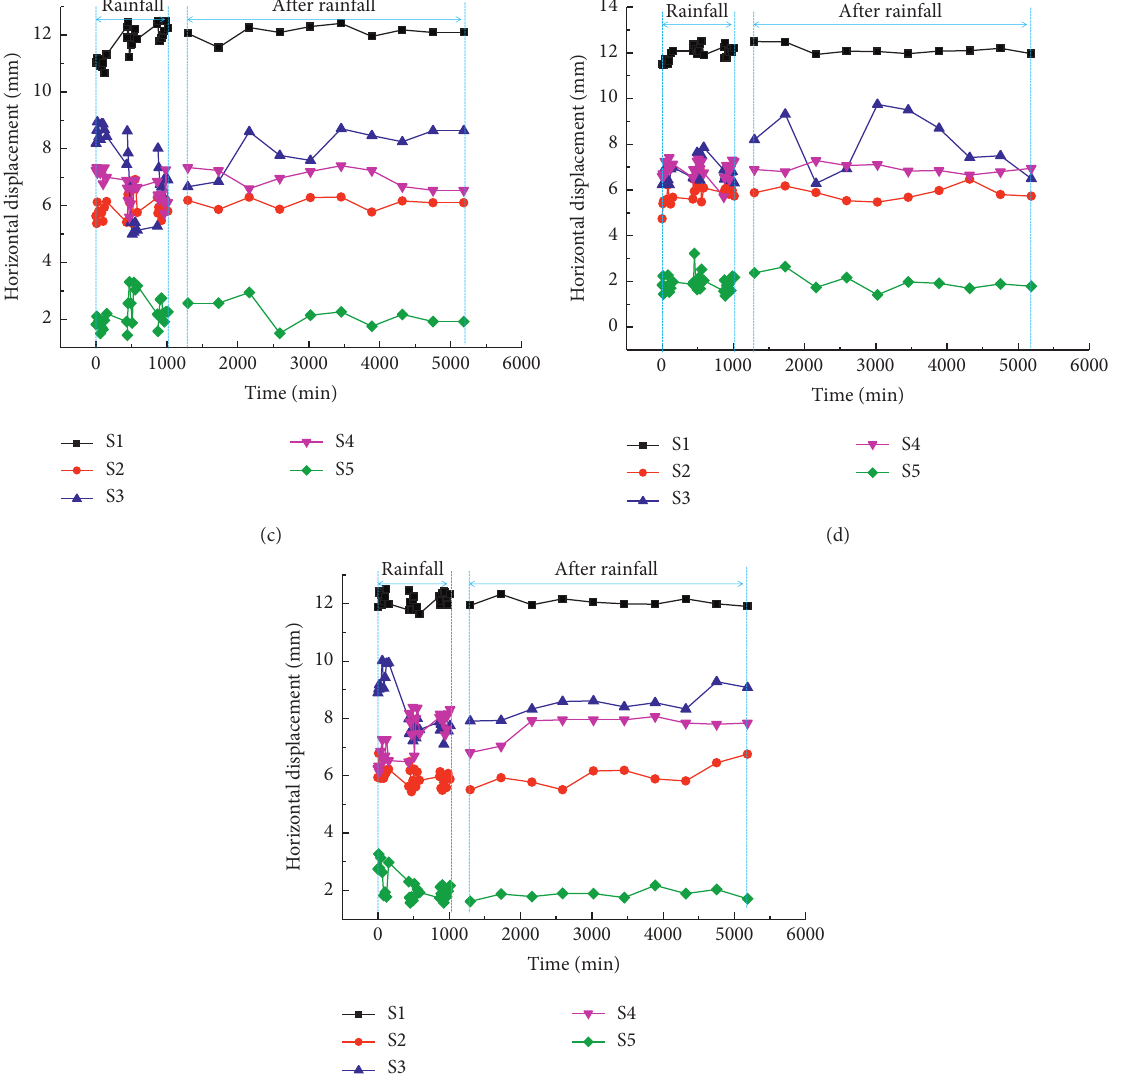
Figure 15: Variations of horizontal displacements of the five key points with time. (a) First year. (b) Second year. (c) Third year. (d) Fourth year. (e) Fifth